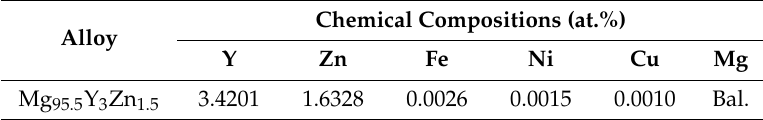
Table 1. Chemical compositions of the studied alloy. Chemical Compositions (at.%) Alloy Y Zn Fe Ni Cu Mg Mg 95.5 Y 3 Zn 1.5 3.4201 1.6328 0.0026